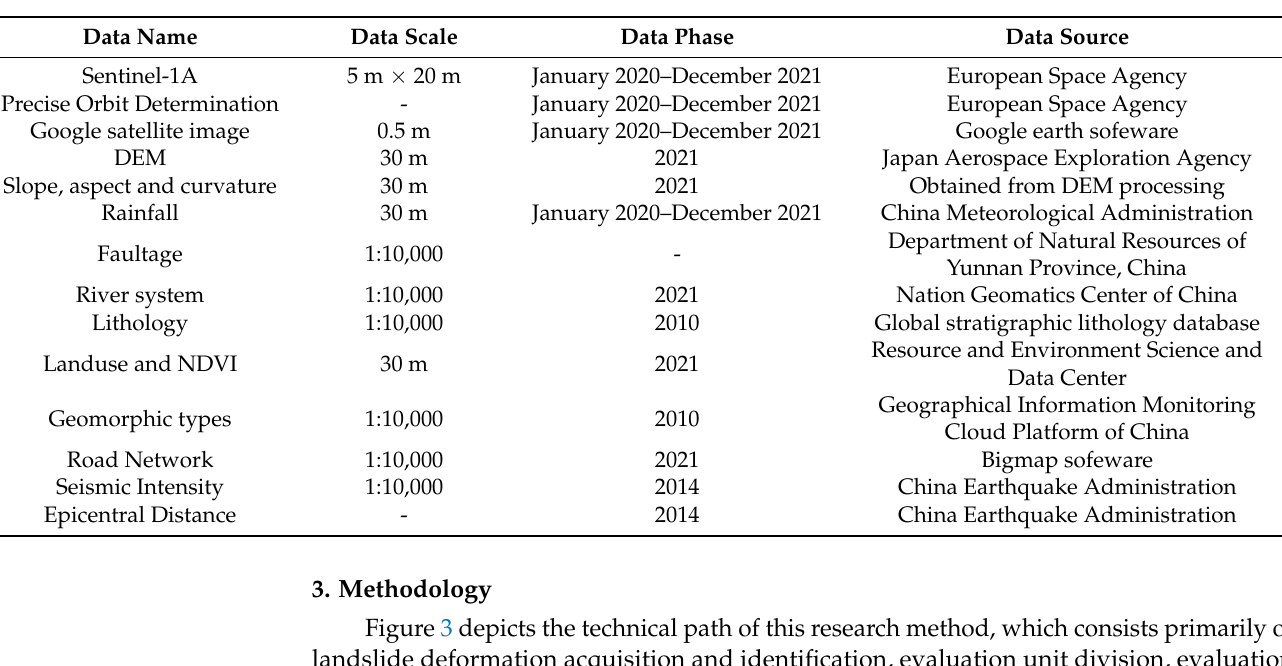
Table 1. List of data sources.